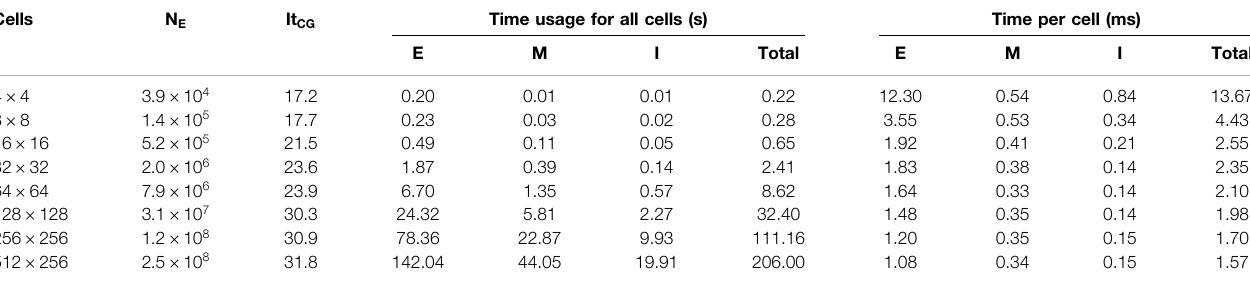
TABLE 8 | Time required to solve a time step of size Δ t (cid:2) 0 . 02 ms for geometries ranging from 4 × 4 cells to 512 × 256 cells using System A (see Section 4.4 ). Cells N E It CG Time usage for all cells